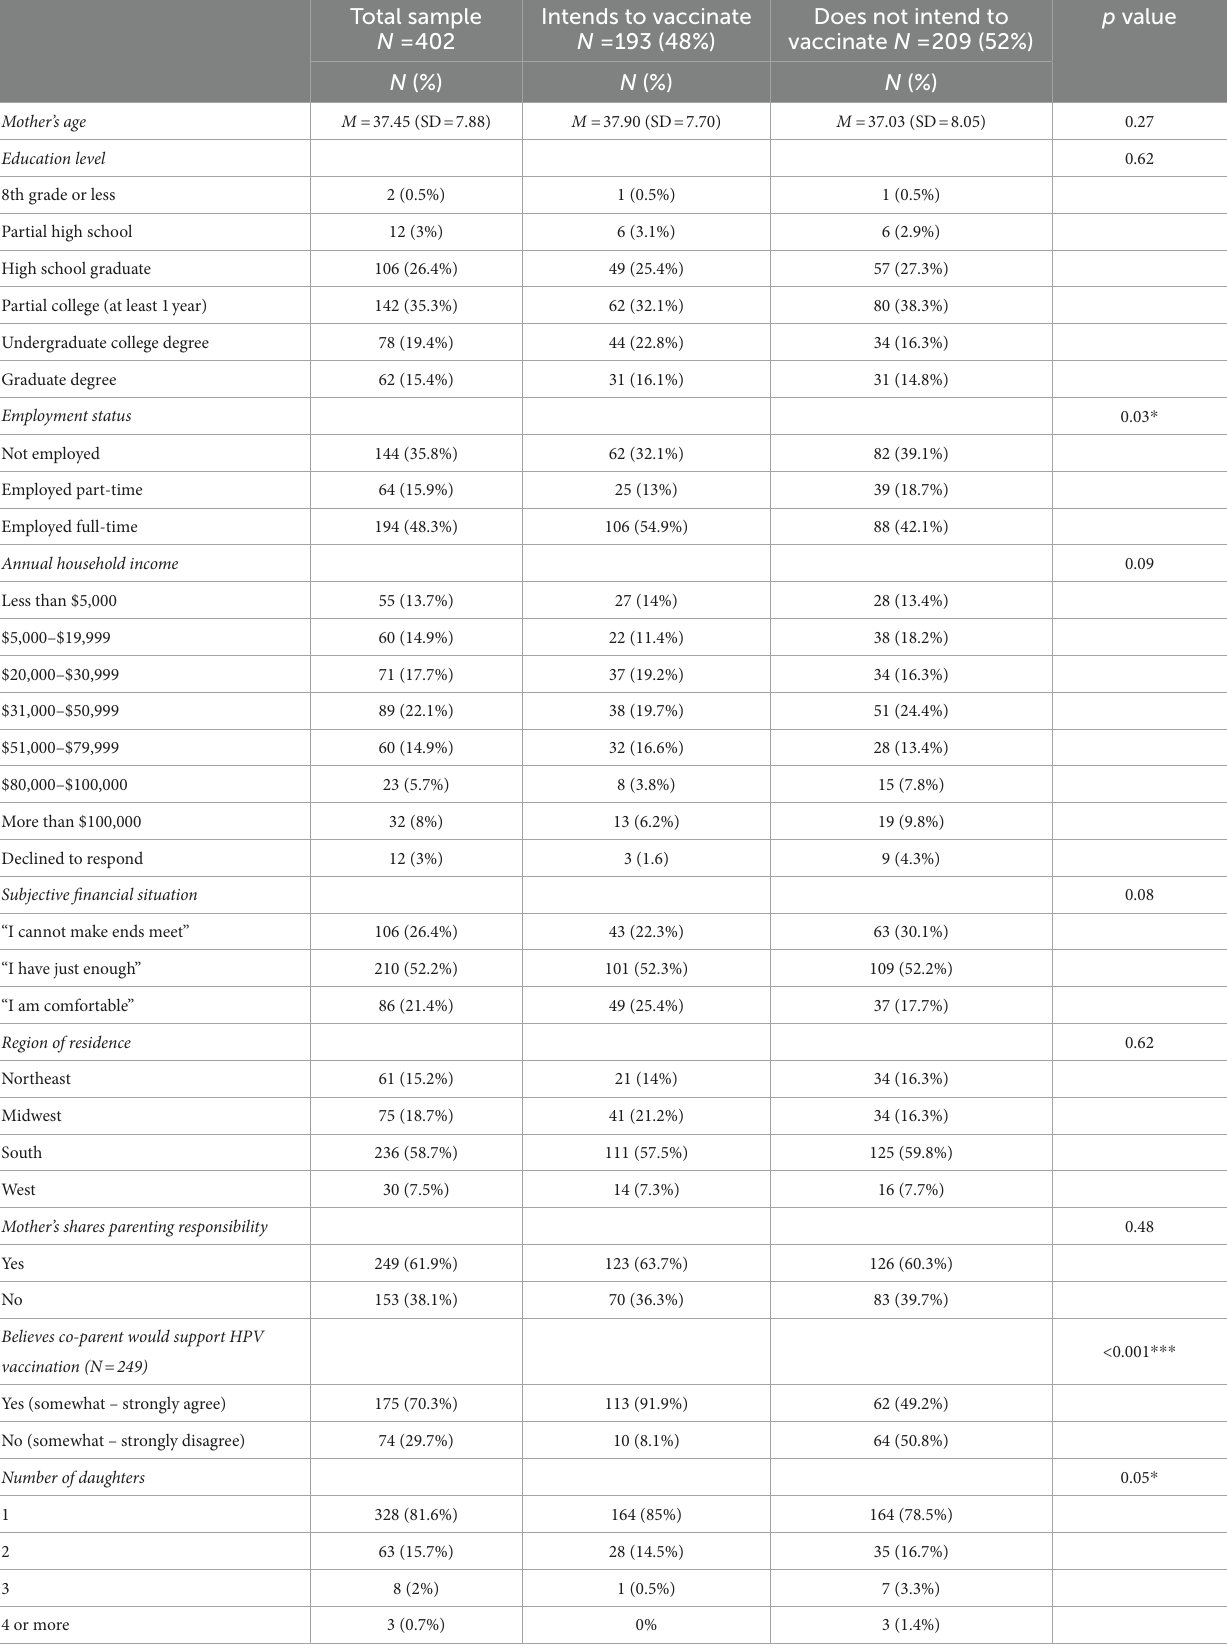
TABLE 1 Differences in demographics and participant characteristics by HPV vaccine intentions.